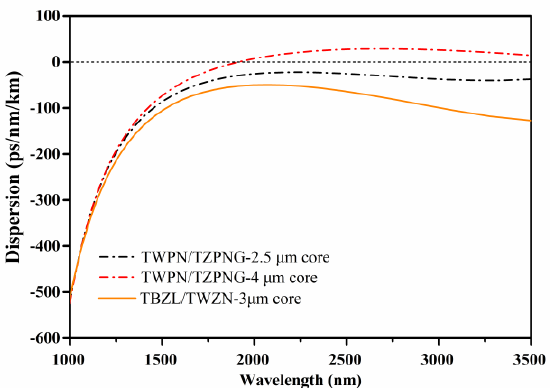
Figure 3. Calculated dispersion of the step−index fluorotellurite glass fibers spanning from 1000 nm to 3500 nm.